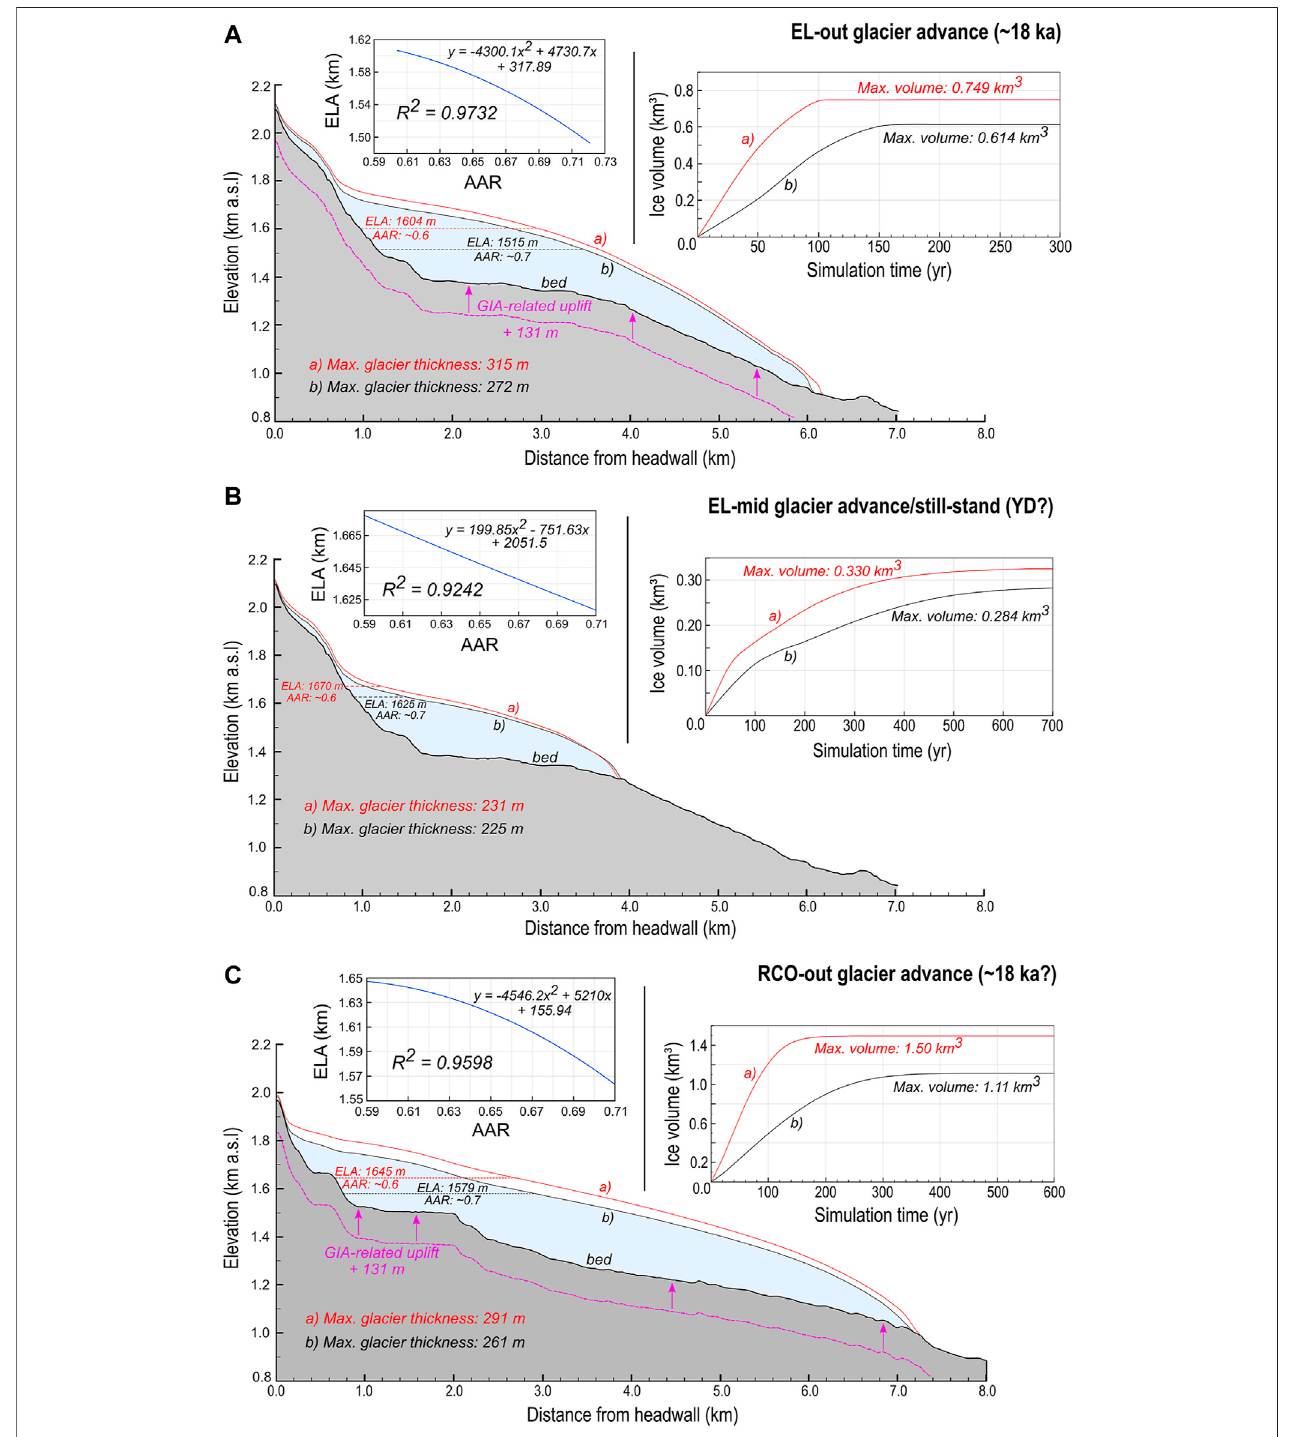
FIGURE7| Elevation pro fi legraphs(above present-day sea level)ofbedrock topography (AW3D30DEM data) and simulated steady-stateice thickness alongthe centralglacier fl owlinefortheEL-out (A) ,EL-mid (B) andRCO-out (C) simulations.Thepurpledashedlinesdenotetheestimatedformerbedsurfaceelevationatthetime of the EL-out advance, prior to GIA-related uplift (131 m). For each pro fi le graph, the two ice-surface pro fi les highlighting maximum and minimum simulated ice- thicknesses for a given advance/still-stand are represented. These two pro fi les also represent boundary AAR values (0.6 vs. 0.7). Each panel also features an ice- volume time series line graph for minimum and maximum ice-volume simulations, as well as a standard regression analysis establishing the best- fi t second-degree polynomial relationship between ELAs (km a.s.l.) and AARs for all simulations of a given glacier reconstruction.